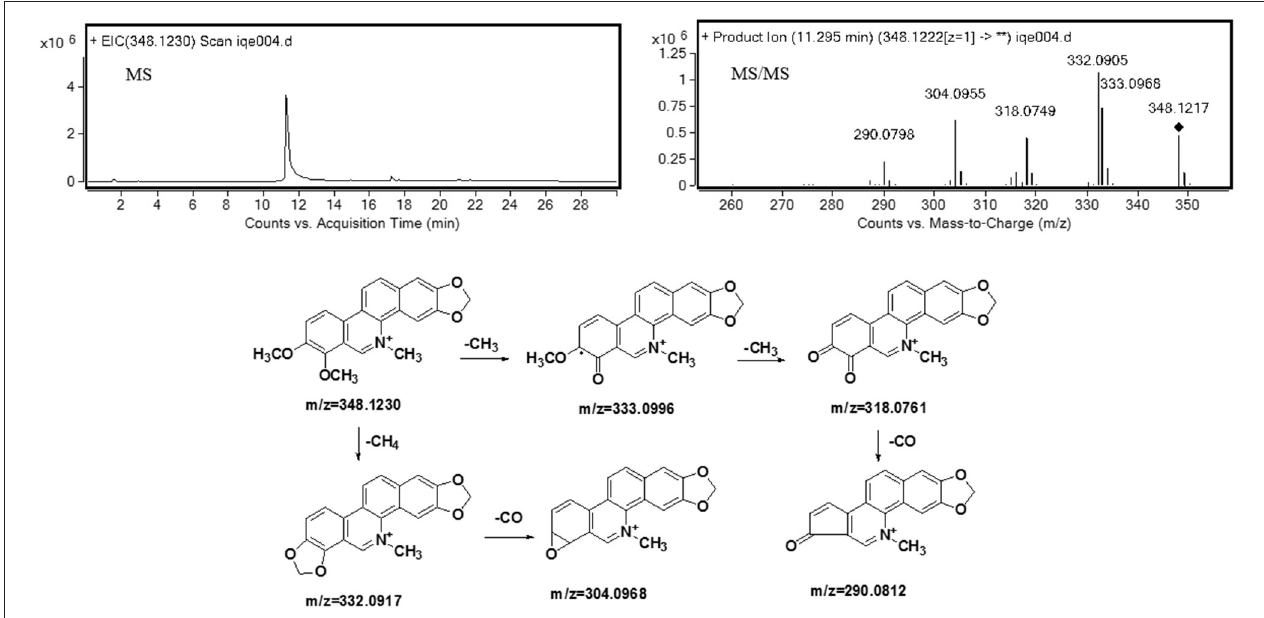
FIGURE 2 | Accurate MS, MS 2 spectra, and proposed fragmentation pathways of